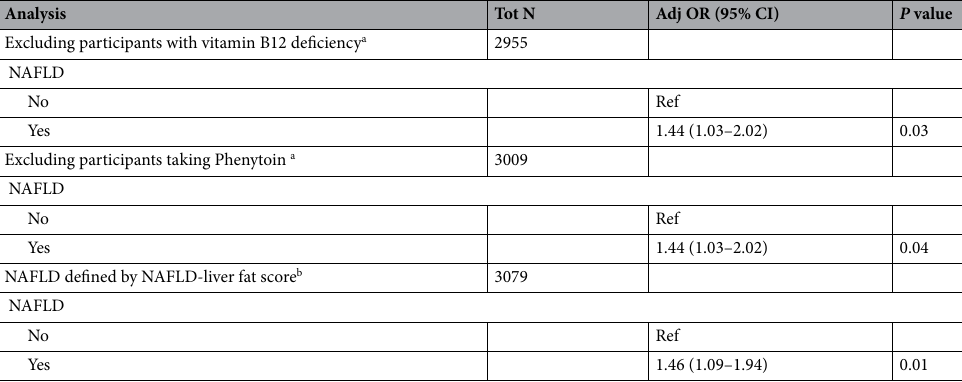
Table 4. Sensitivity analyses. NAFLD non-alcoholic fatty liver disease, BMI body mass index, PIR poverty income ratio, PA physical activity, OR odds ratio, CI confidence interval, Ref reference, Tot N total number. a Adjusted for age, gender, ethnicity, education, smoking status, alcohol consumption, PA, PIR, Hypertension, Hyperlipidemia, Diabetes and BMI. b Adjusted for age, gender, ethnicity, education, smoking status, alcohol consumption, PA, PIR, Hypertension,